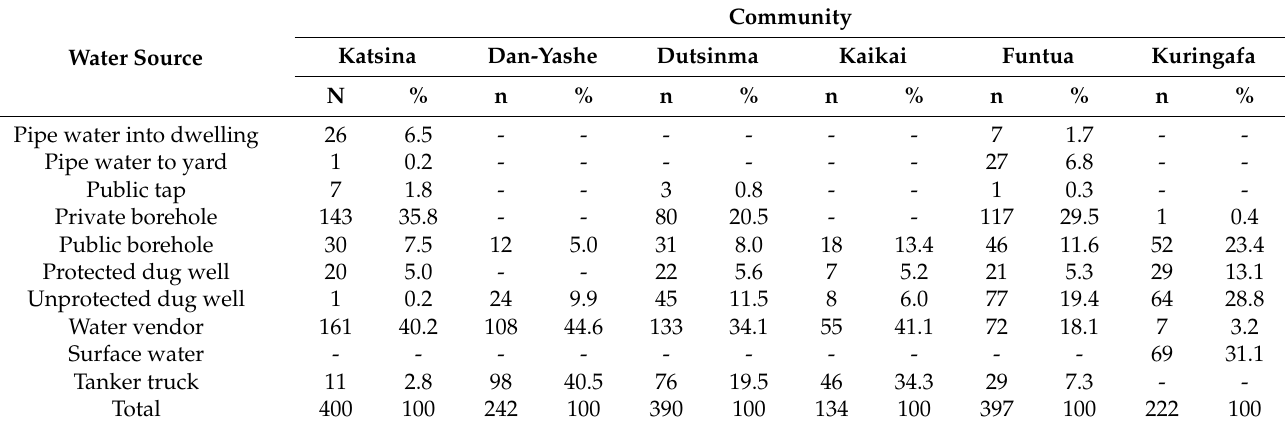
Table 5. Various household water sources across the sampling